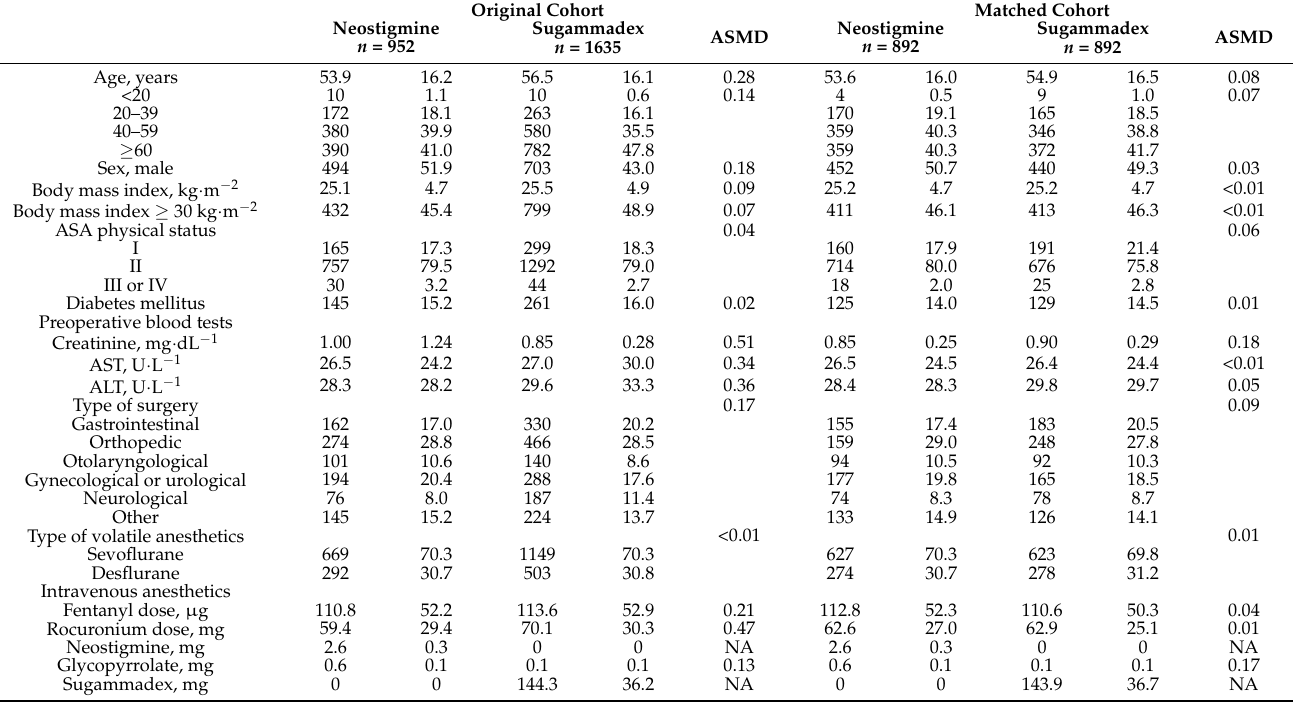
Table 1. Distributions of baseline patient characteristics of the sugammadex and neostigmine groups. Original Cohort Matched Cohort